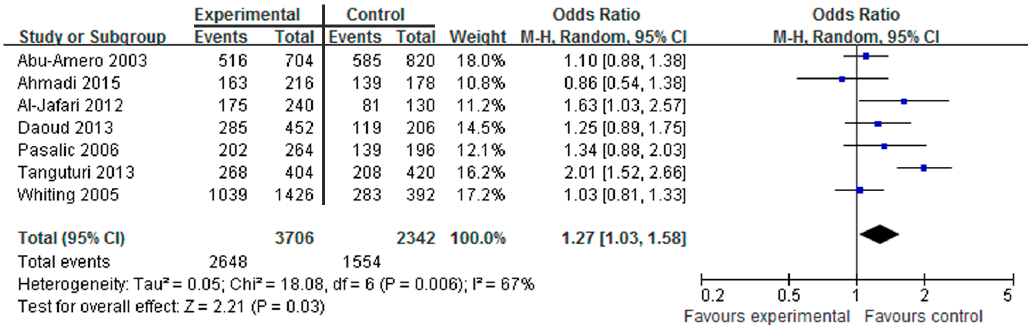
Figure 3. Forest plot of HindIII H + allele genotype associated with CAD risk.